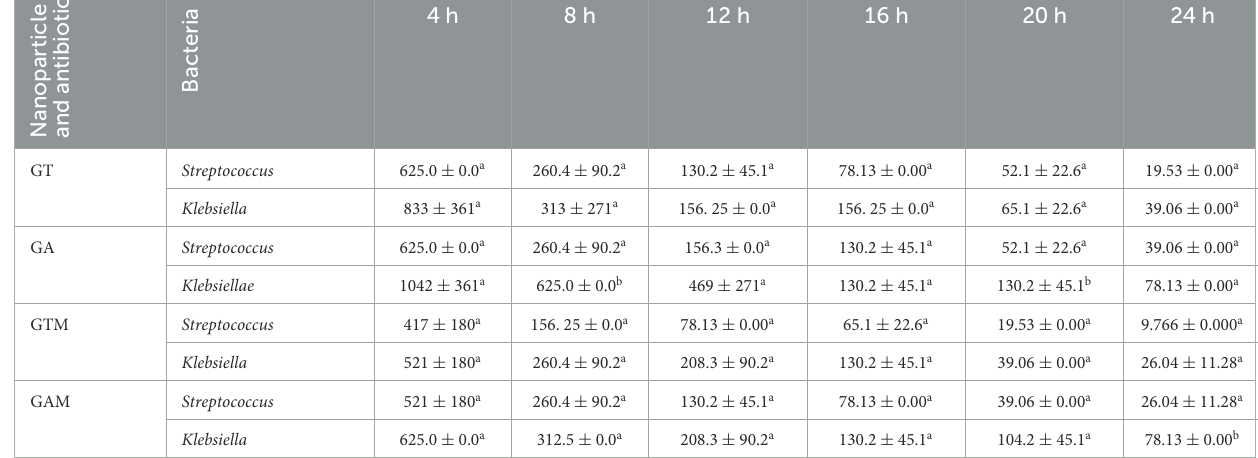
TABLE 6 Minimum inhibitory concentration ( µ g/mL) of K. pneumoniae and S. agalactiae against different gel-based